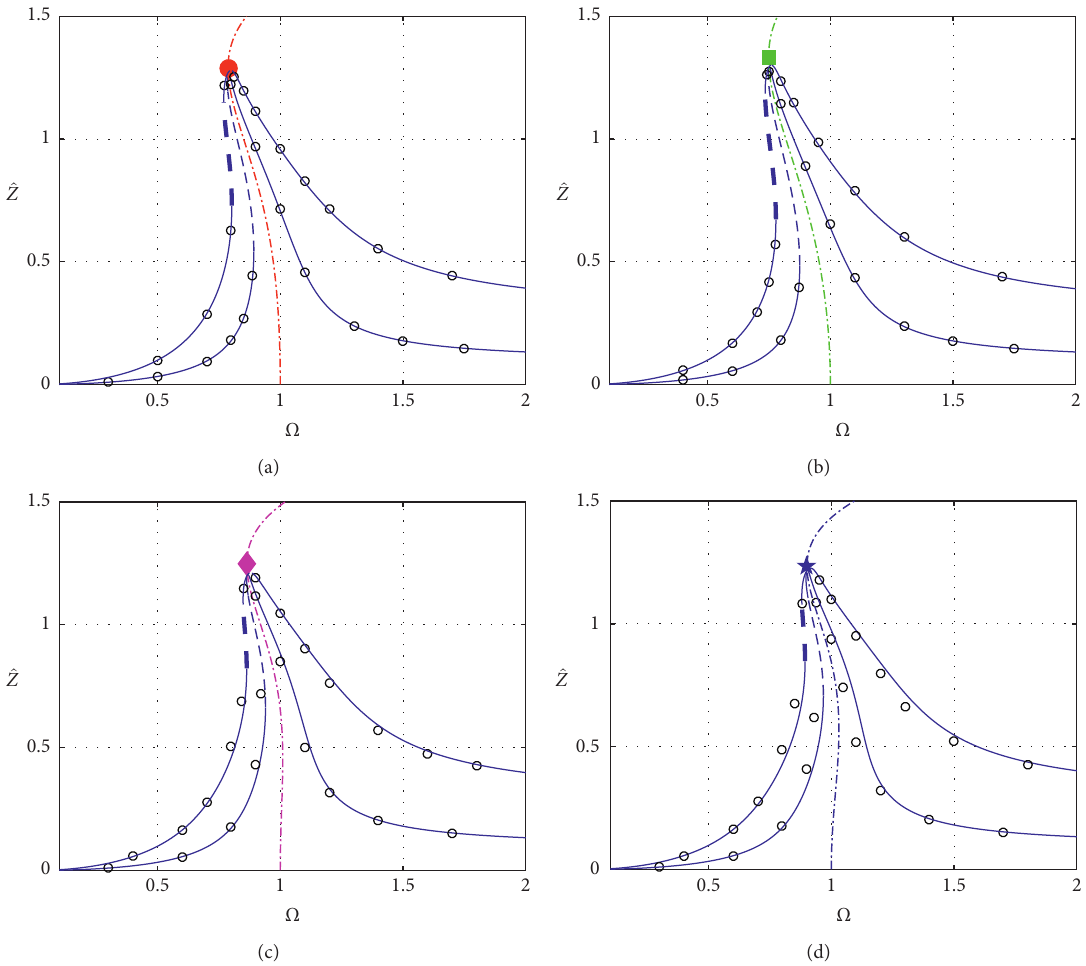
Figure 13: FRCs of the X -shaped suspension with QZS behaviour at large deflections for 􏽢 Y � 0 . 1(thin lines) and 􏽢 Y � 0 . 3 (thick lines), and different values of the system parameters as indicated by the circle (a), square (b), diamond (c), and star (d) in Figures 5 and 6. The damping is set according to equation (20). Stable analytical solutions are represented as solid lines; unstable analytical solutions are represented as dashed lines; numerical solutions are represented as empty circles; resonance peaks are represented as representative marker; and backbone curve are represented as dash-dotted